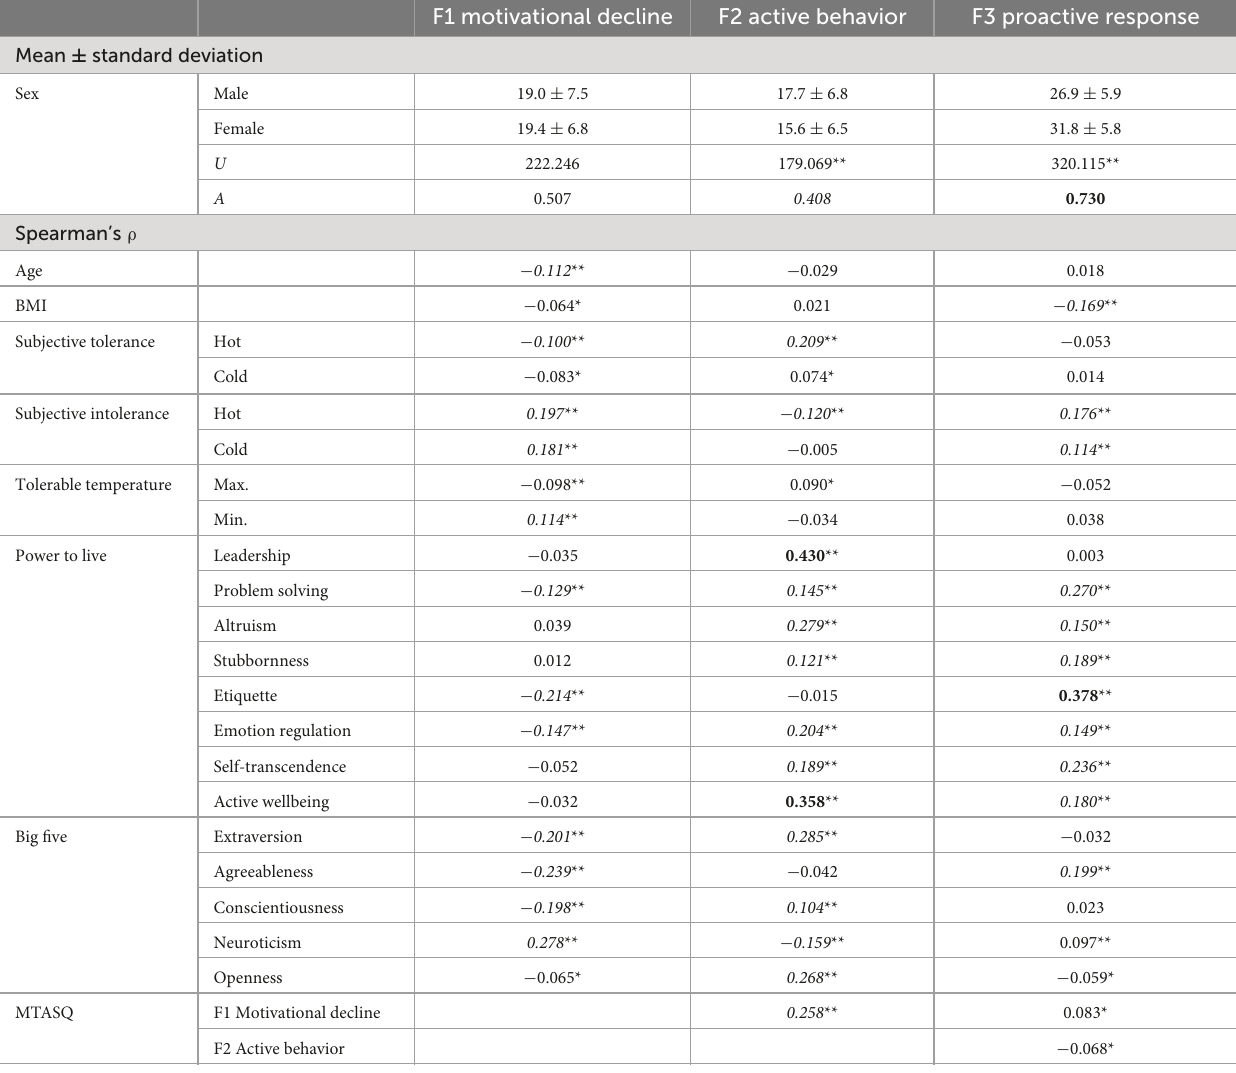
TABLE 2 Associations between the scores on the Multidimensional Thermal Adaptation Style Questionnaire and the